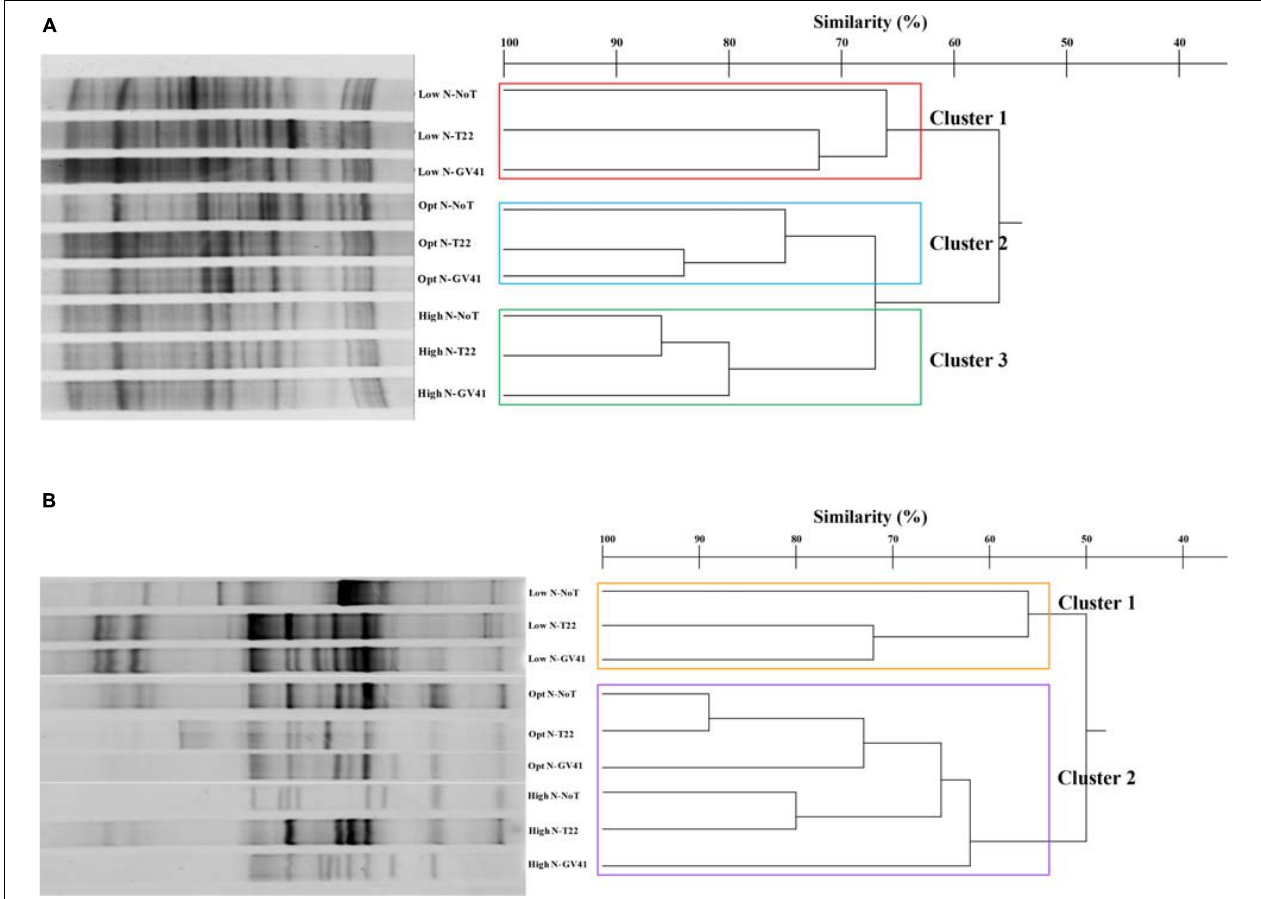
FIGURE 5 | DGGE profiles and dendrogram showing the degree of similarity (%) of the PCR-DGGE profiles of the prokaryotes (A) and eukaryotes (B) in rhizo-soil samples from rocket. Low N, non-fertilized conditions (low N availability); Opt N, optimal N fertilization, amounting to 60 kg N ha − 1 ; High N, supraoptimal N fertilization, amounting to 120 kg N ha − 1 ; NoT, non-inoculated control; T22, T. harzianum strain T22; GV41, T. virens strain